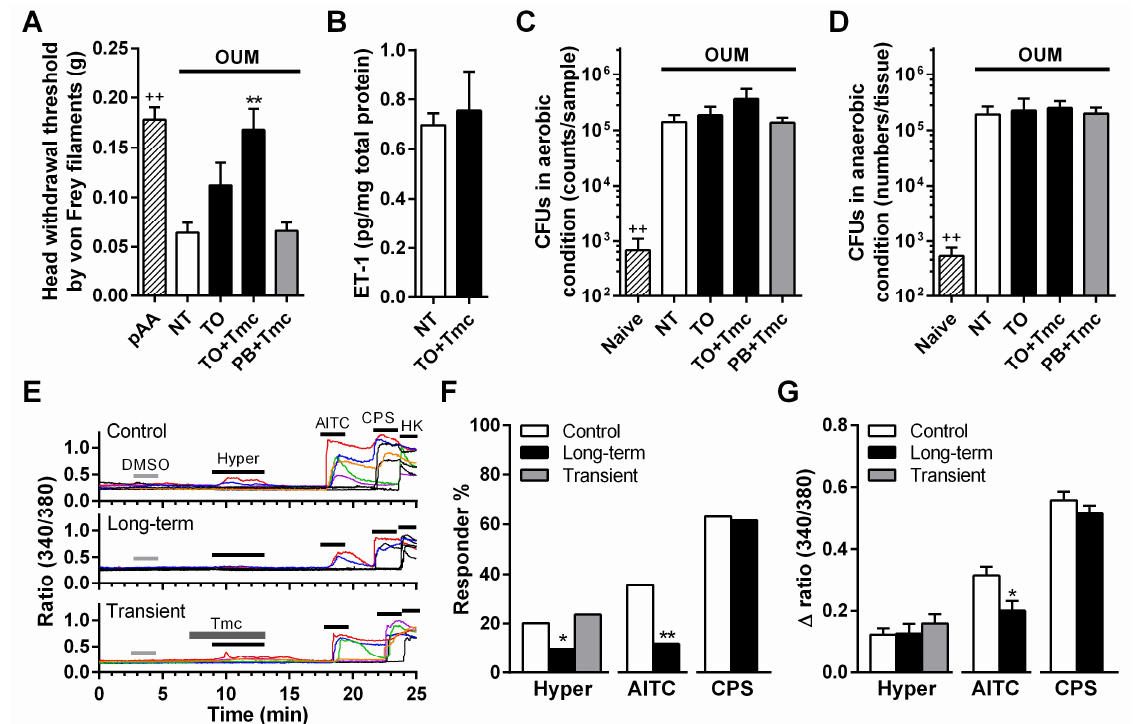
Figure 4. Analgesic effect of triamcinolone acetonide (Tmc)-containing Traful ointment (TO) on oral ulcerative mucositis- induced mechanical allodynia and its cellular mechanism. ( A ) Effects of ointments on oral ulcerative mucositis-induced mechanical allodynia. NT: non-treated oral ulcerative mucositis model (OUM), (pAA: before the acetic acid procedure in the same rats), TO: TO alone, TO + Tmc: TO with Tmc and PB + Tmc: Plastibase with Tmc; each group n = 5. ++ p <